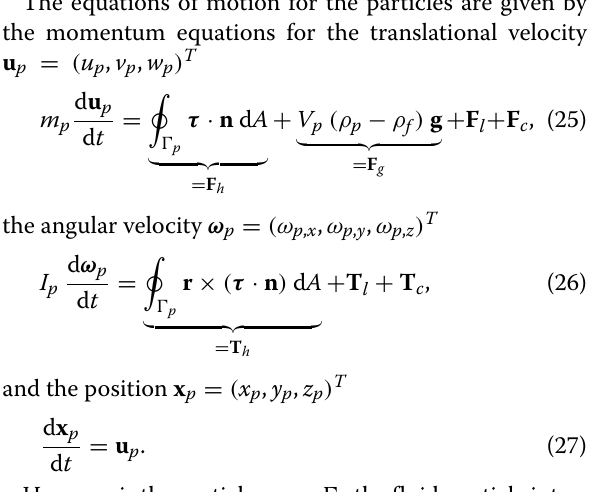
Table 1 Comparison of numerically and experimentally measured front velocity